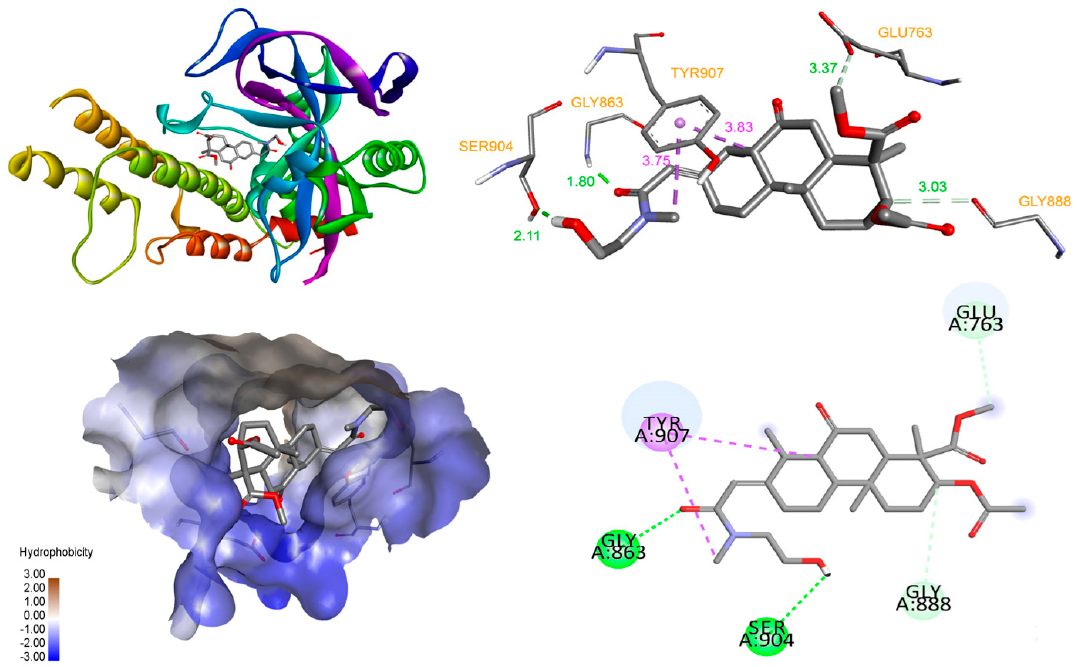
Figure 6. Interaction diagram of compound with PARP-1.